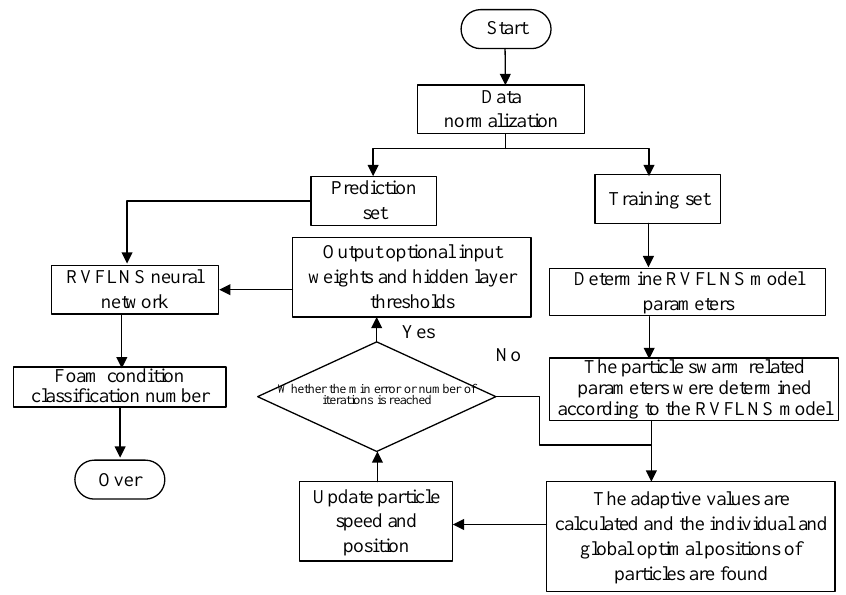
Figure 7. PSO-RVFLNS algorithm flow.